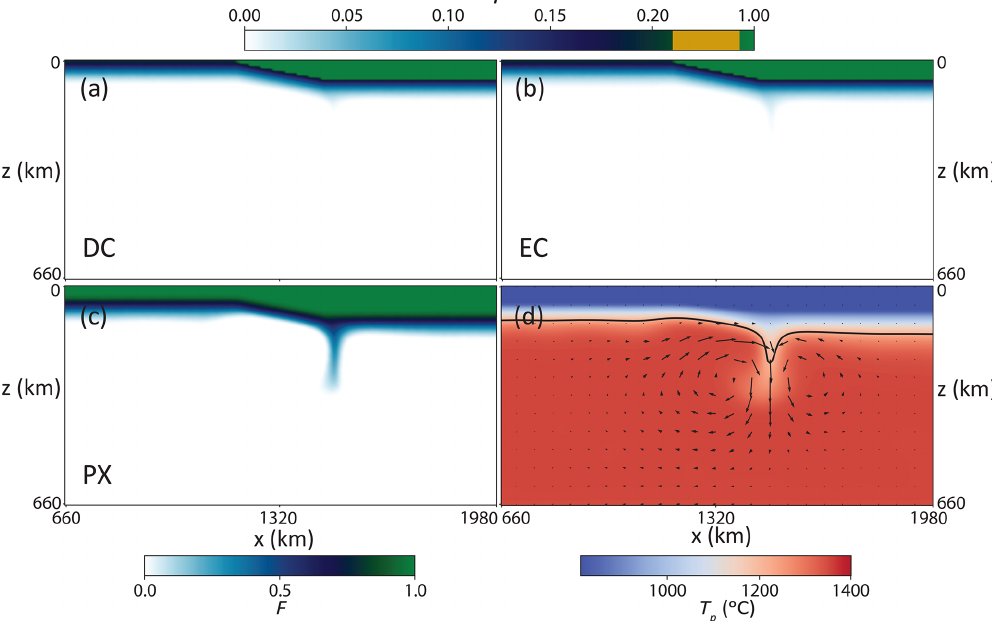
Figure A2. Snapshots of composition and temperature of the same time step of the reference model as shown in Fig. 3b. Panels (a) and (b) show melt depletion of the peridotitic compositions: DC and EC, respectively. Panel (c) shows the same field for the pyroxenitic (PX) component. Panel (d) is identical to Fig. 3b. Note that while the depleted lithospheres of peridotitic components are barely eroded and entrained by EDC (with EC being slightly more affected), this is not true for the depleted part of the PX component, which is more efficiently removed by the mantle flow. Also note that the scale for (c) is different than that of (a) and (b)